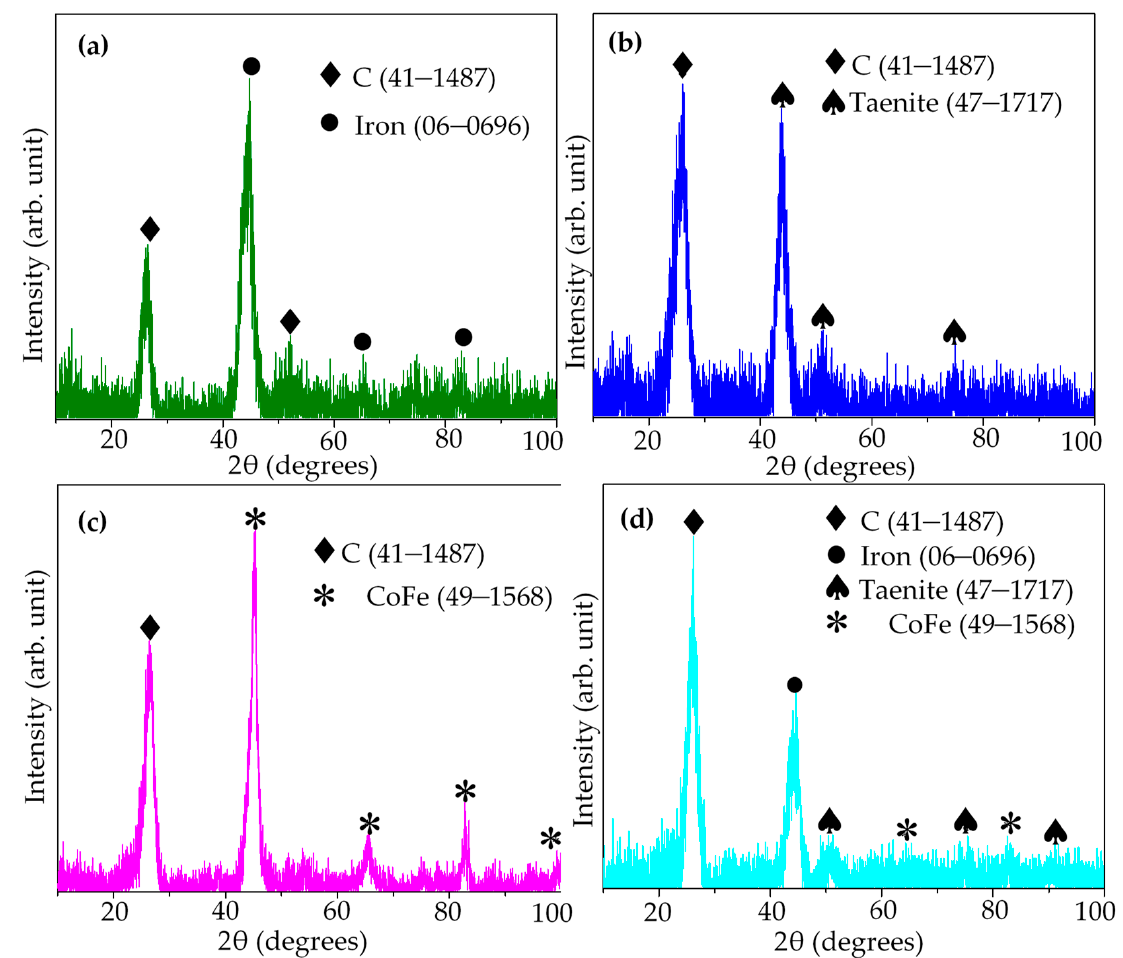
Figure 11. XRD spectra of the CNT sheet samples from the fuels II–V: ( a ) Fuel II, ( b ) Fuel III, ( c ) Fuel Figure 11 . XRD spectra of the CNT sheet samples from the fuels Ⅱ –V: ( a ) Fuel II, ( b ) Fuel III, ( c ) Fuel IV, ( d ) Fuel IV, ( d ) Fuel V.